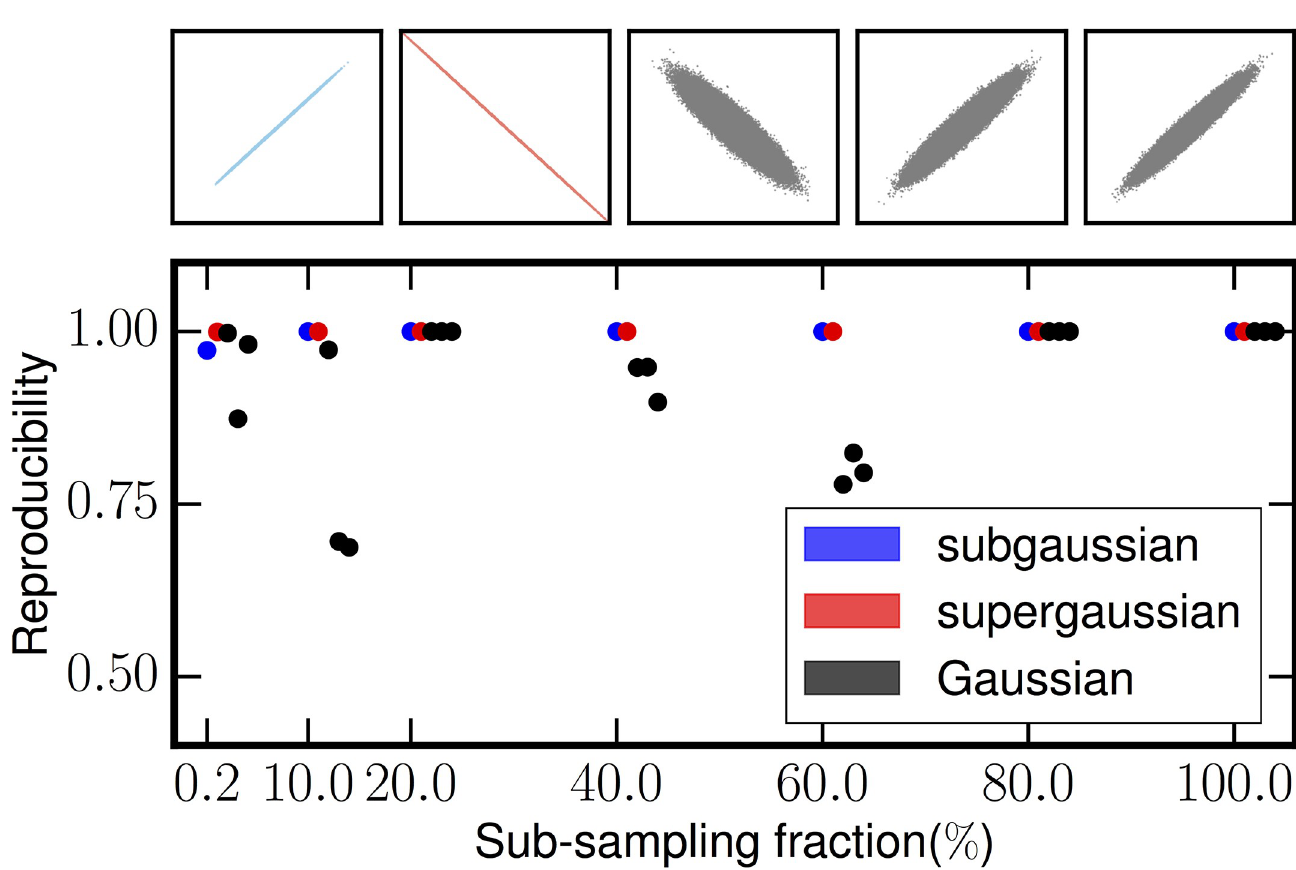
Fig 3. Full rank extraction. We constructed a simulateddata matrix with five sources: one supergaussian, one subgaussian, and three Gaussian sources. The simulateddata matrix had 5 × 10 5 samples. The main panel shows the results of RAICAR extractions at different levels of decimation, includingthe parent data. The best assignmentmatch to the supergaussian source is shown in blue and to the subgaussiansource in red. While the Gaussian sources may sometimes have extrememly high reproducibility, they show poor stability when the data is decimated,in constrast to the sparse sources. The top panel shows scatter plots of the estimated sources from the parent data againsttheir best assignmentmatch; the sparse sources are recoveredperfectly by RAICAR.